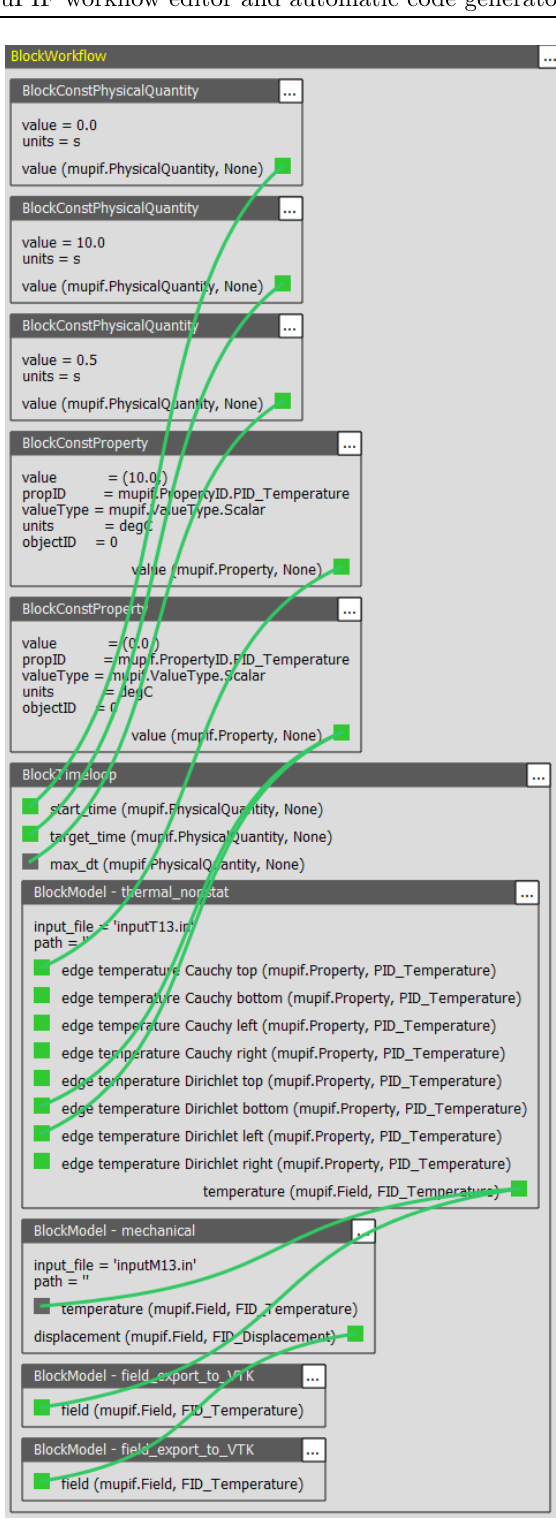
Figure 4. Execution workflow of the thermo- mechanical